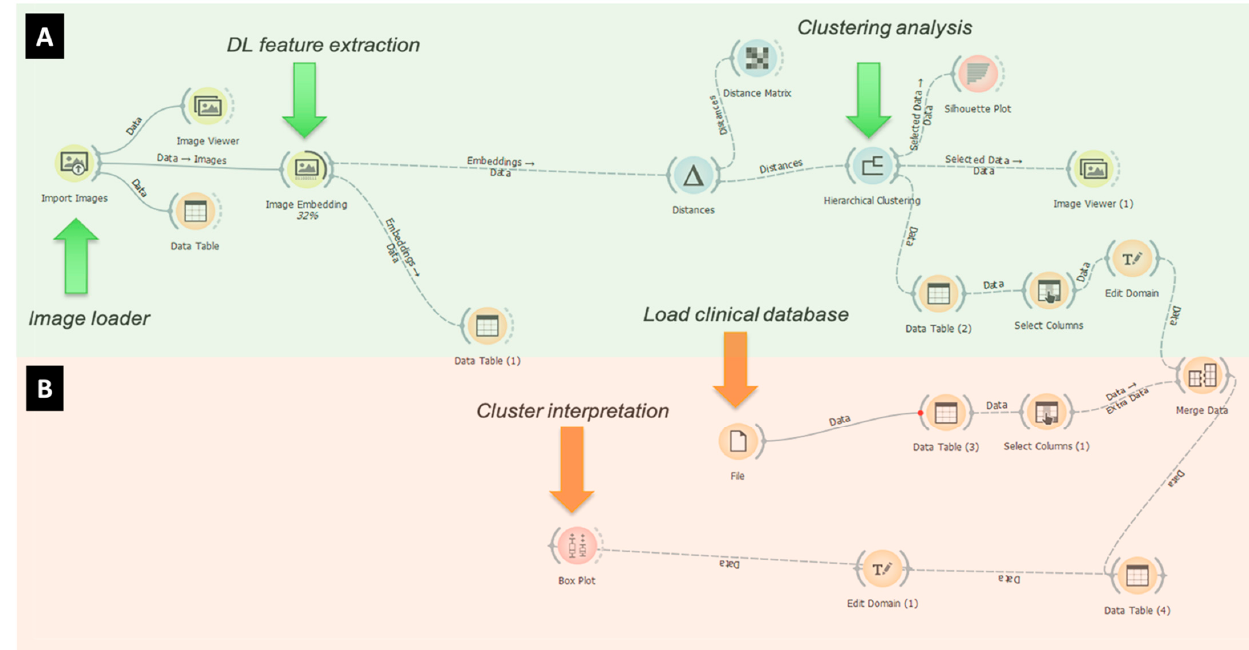
Figure 3. Deep learning clustering flow analysis on OCT angiography images. First steps ( A ) are represented by “image loader”, “deep learning (DL) feature extraction” and “clustering analysis” (green arrows). Second steps ( B ) are made up of “load clinical database” and “cluster interpretation” (orange arrows).